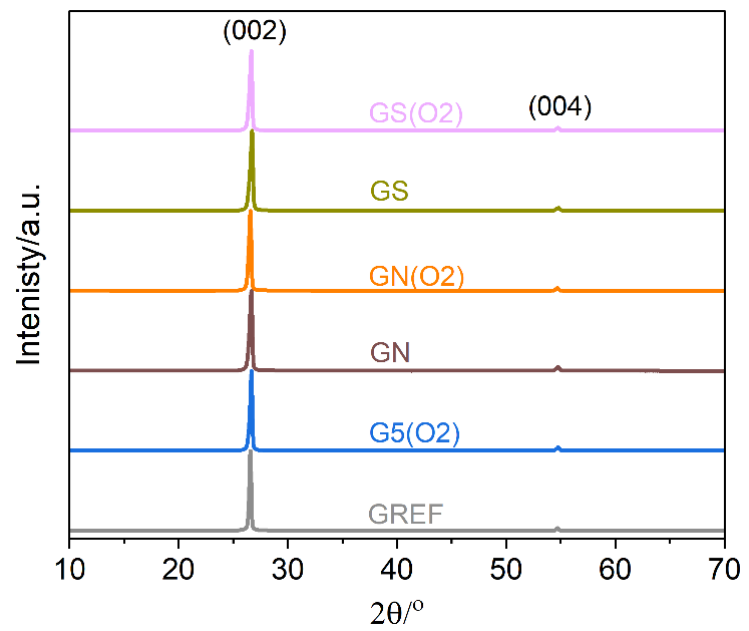
Figure 4. Powder X-ray diffractograms of the studied samples: reference-GREF, 5 min oxygen Figure 4. Powder X ‐ ray diffractograms of the studied samples: reference ‐ GREF, 5 min oxygen plasma-treated-G(O2), nitric acid-treated-GN, nitric acid + oxygen plasma-GN(O2) treated, sulfuric plasma ‐ treated ‐ G(O2), nitric acid ‐ treated ‐ GN, nitric acid + oxygen plasma ‐ GN(O2) treated, sulfuric acid-treated-GS, and sulfuric acid + oxygen acid ‐ treated ‐ GS, and sulfuric acid + oxygen plasma ‐ GS(O2).